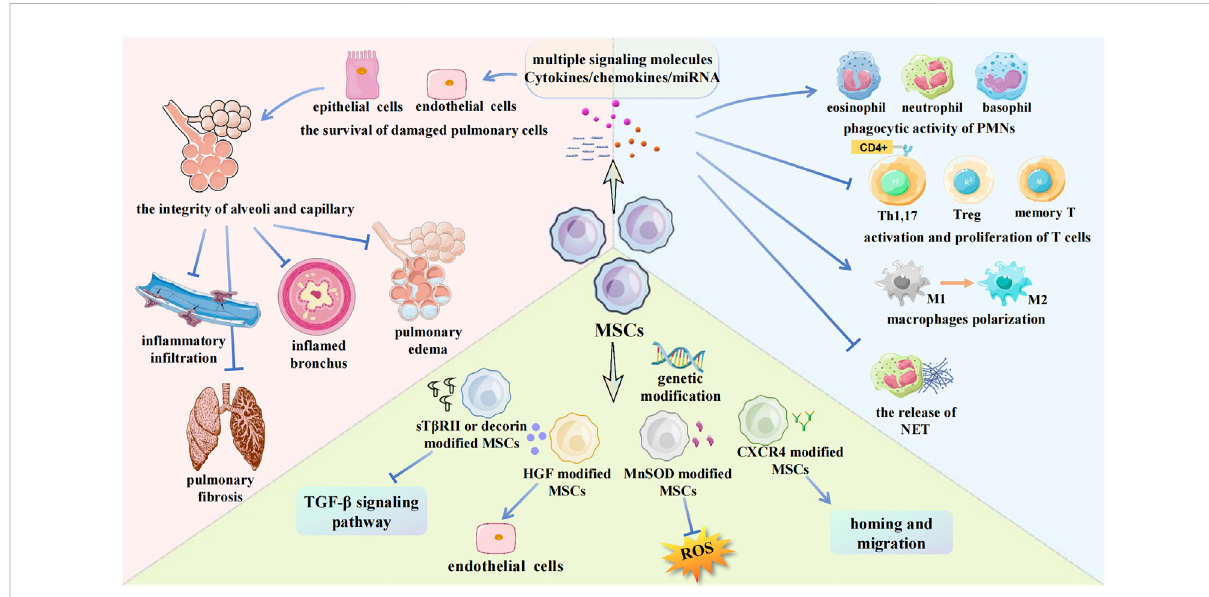
FIGURE 3 Some mechanisms about MSCs for RILI in current researches. The main methods to apply MSCs in RILI are showed in the picture. MSCs can regulate multiple signaling molecules, which protect pulmonary cells. MSCs inhibit leukocytes in fi ltration and regulate leukocytes function. Geneticallymodi fi edMSCscanstrengthentargetgeneexpression.PMNs,Polymorphonuclearleukocytes;Treg,RegulatoryTcell;sT β RII,TGF- β type II receptor; HGF, Hepatocyte growth factor; MnSOD, Manganese superoxide dismutase; CXCR4, CXC-chemokine receptor 4; TGF- β , Transforming growth factor